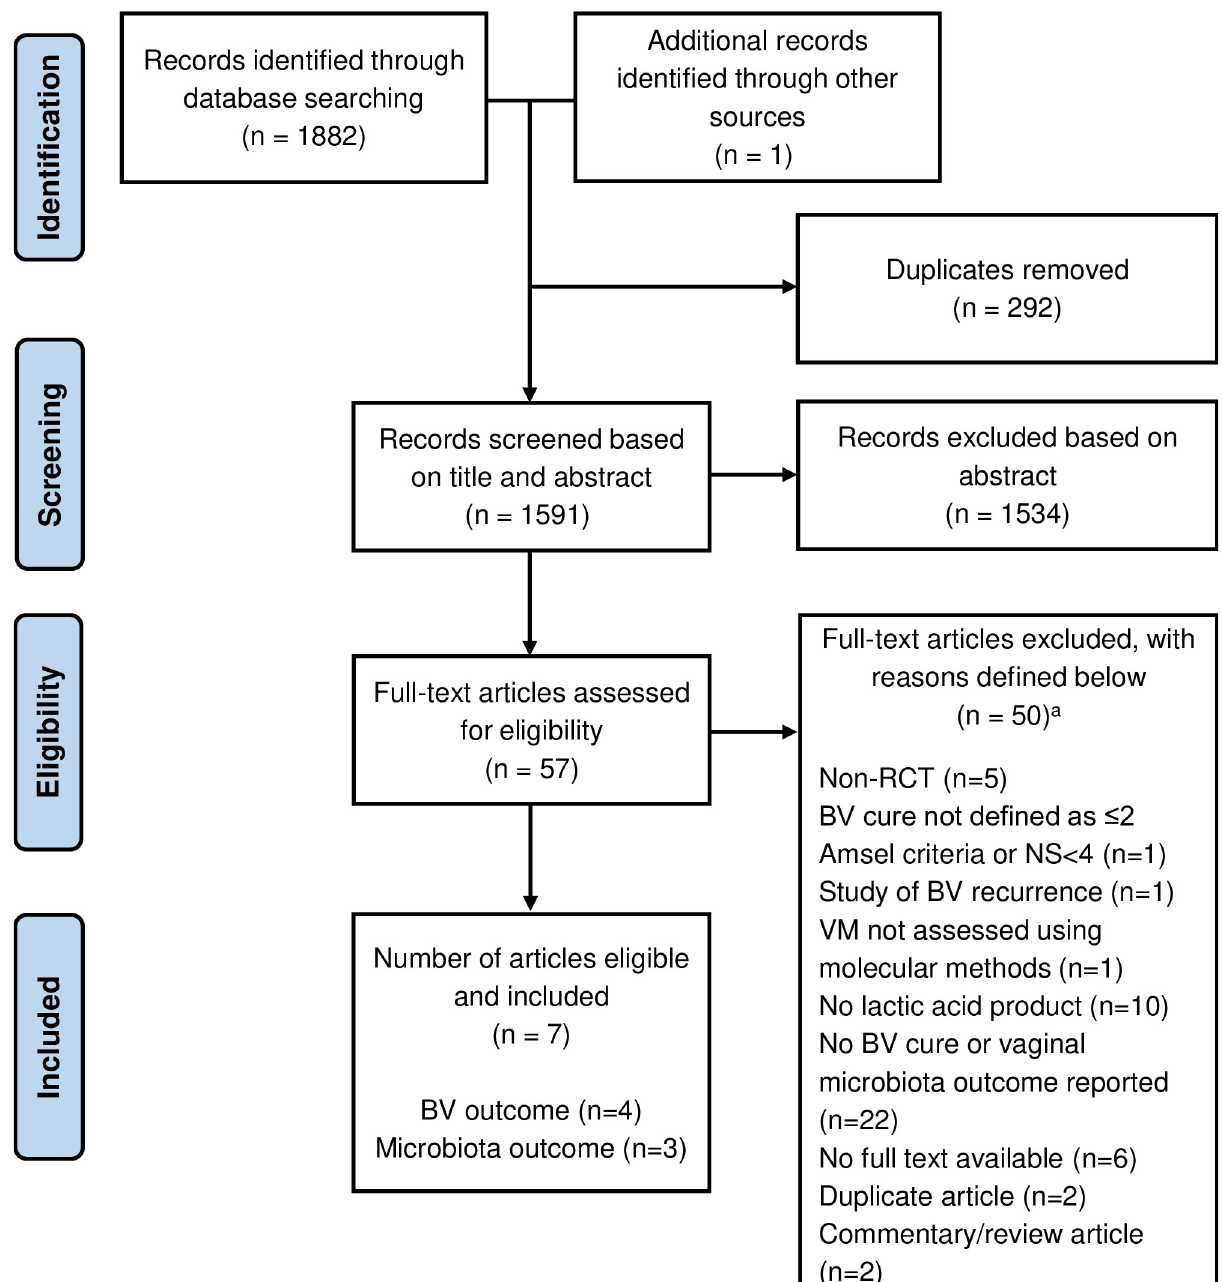
Fig 1. PRISMA flow diagram describing the literature search and article selection process. a Detailed reasons for exclusion are provided in S3 Table. metronidazole bid plus nightly placebo pessary for seven days, or oral placebo bid plus nightly placebo pessary for seven days. No details of allocation concealment or blinding were provided (Fig 2). Cure was assessed at three time points (2-weeks, 4-weeks and 3-months after the start of treatment) using � 2 of 4 Amsel criteria and an additional author definition called ‘strict’ cure (absence of: positive amine test, clue cells, pH > 4.5). Two weeks after the start of treat- ment, 49% (n = 18/37) of women receiving lactic acid, 83% (n = 35/42) of women receiving